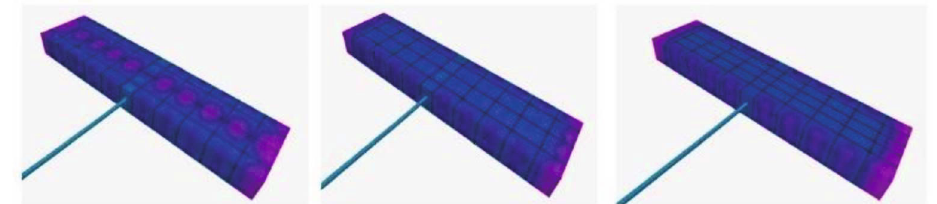
Figure 8: Fracturing model with di ff erent numbers of fracture clusters.